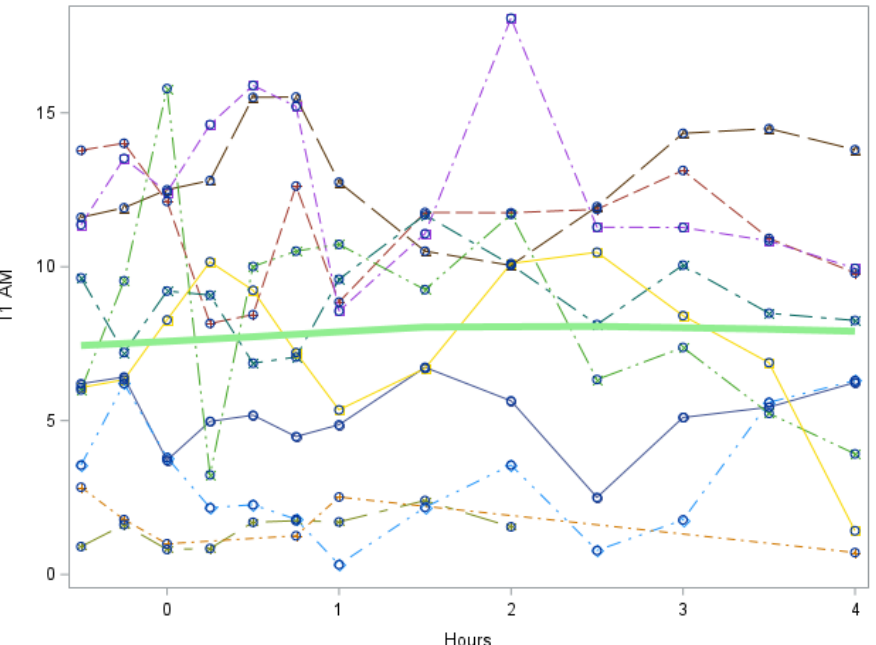
Figure A1. Study 1: 3-T1AM trend in first 5 h after LT3 dose (Each individual line represents a participant. The green line represents the mean values for all participants). 3-T1AM = 3-T1AM con- centration in nmol/L. Slope of line = − 0.14, p value = 0.3687. This indicates that there is no significant trend in 3-T1AM during the first 5 h. Figure A2. Study 1: 3-T1AM trend over all hours after LT3 dose (Each individual line represents a participant. The green line represents the mean values for all participants). 3-T1AM = 3-T1AM